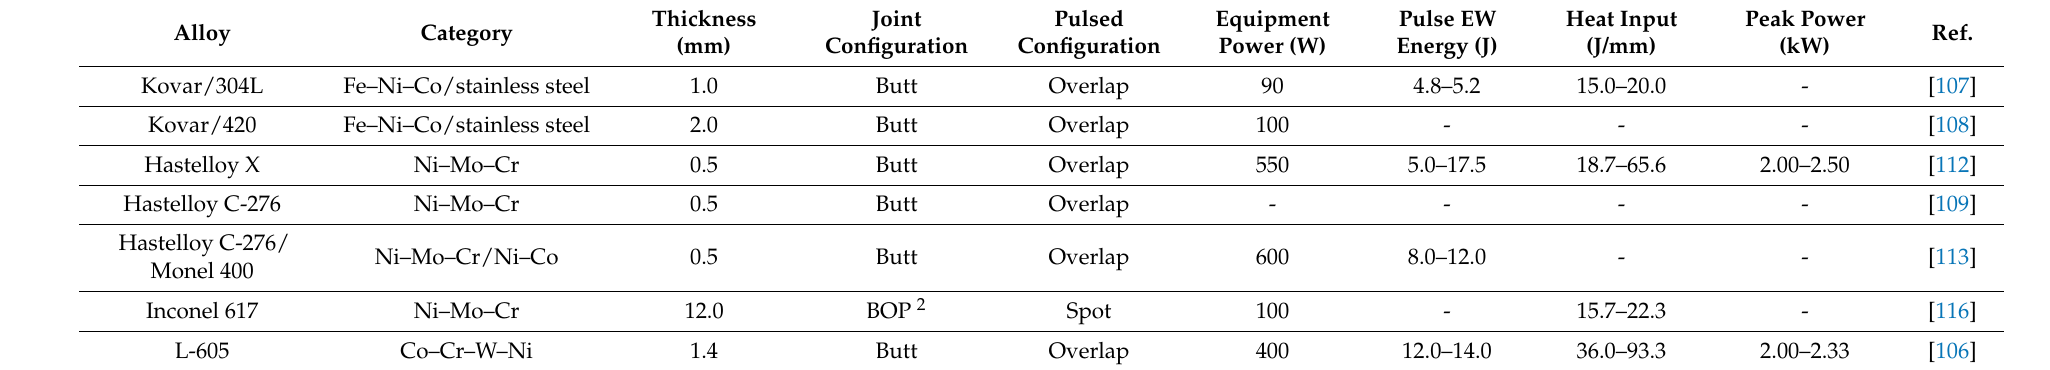
Table 10. Details of welding conditions applied to superalloy pulsed laser 1